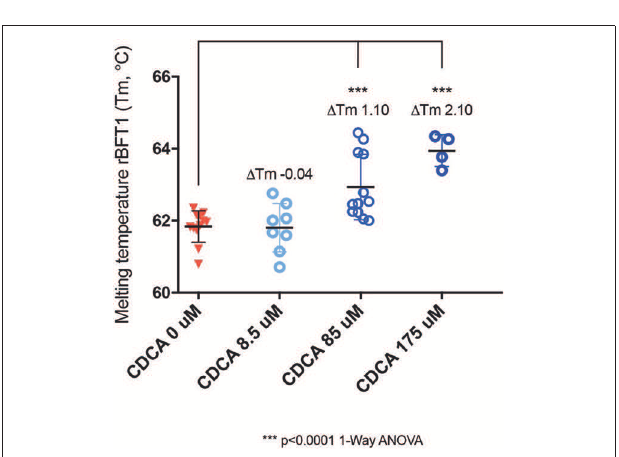
FIGURE 7 | CDCA interacts directly with recombinant BFT-1. TSA with CDCA and rBFT-1 ( N = 3), where CDCA resulted in a significant shift in melting temperature at concentrations of 85 and 175 µ M ( 1 Tm 1.10 and 1 Tm 2.10, respectively ( P < 0.0001 for 1-Way ANOVA and Dunnett’s multiple comparison test) when compared to the negative control condition (CDCA 0 µ M). CDCA at a concentration of 8.5 µ M did not result in a significant shift of the melting temperature of rBFT-1. Bars indicate means and standard deviations. N = 4–12 for each